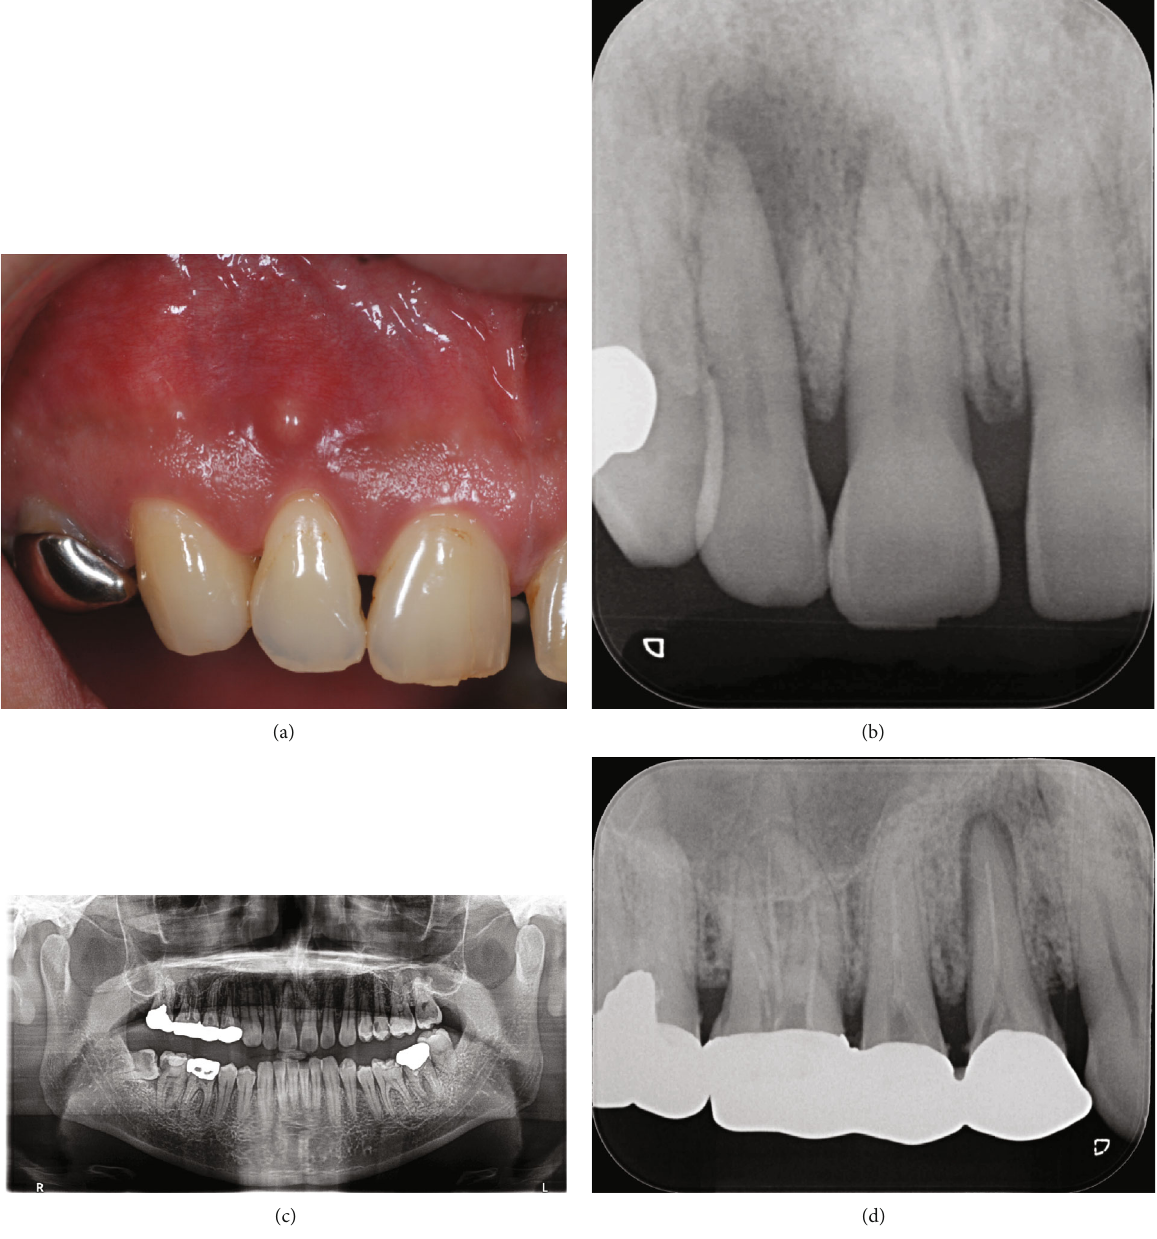
Figure 1: Preoperative photograph and radiographs. Intraoral photographs of the right central and lateral incisor with swelling and spontaneous pain (a). The periodontal pockets were around 1 – 2mm circumferentially, and there was no bleeding on probing sites. Intraoral radiographs showed no carious lesions in either incisor, but radiolucent regions were seen around the apexes of the maxillary right central and lateral incisors (b). Both incisors showed normal responses to the dental pulp cold stimulus test. Panoramic radiographs showed numerous apical and carious lesions in the mouth (c). The closest lesion to the site was the maxillary right fi rst premolar. Intraoral periapical radiographs showed apical lesions of the maxillary right fi rst premolar